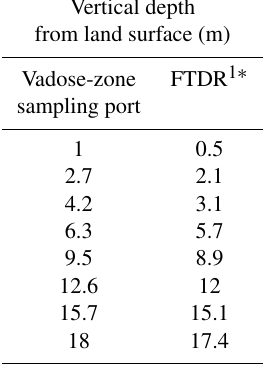
Table 1. Depth distribution of the vadose-zone monitoring system (VMS)